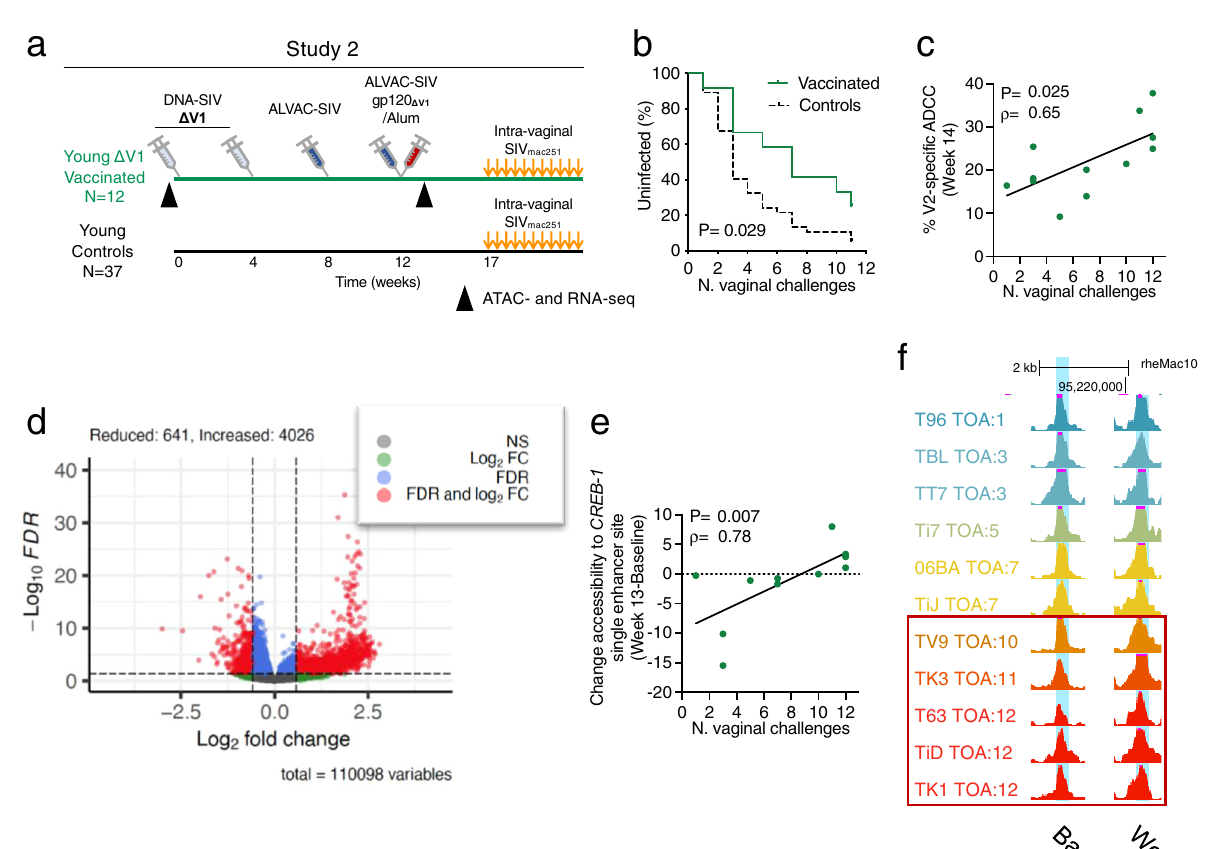
Fig. 3 | Chromatin accessibility to CREB1 . V2 speci fi c ADCC and risk of SIV acquisition. a Schematic study design with time of immunization (weeks 0 – 12) or SIV mac251 challenges (weeks 17 – 27) and time of collection of ATAC- and RNA-seq samples (black triangle). b SIV mac251 acquisition. The number of intravaginal exposures before viral acquisition was assessed in n =12 young animals relative to n =37 historic controls (Log-rank Mantel-Cox test). c Two-tailed Spearman corre- lation and simple linear regression between V2-speci fi c ADCC at week 14 and time of acquisition (TOA) in n =12 animals. d Volcano plot showing in red ATAC-sites with signi fi cantly (FDR<0.05) different accessibility at baseline and week 13 and with absolute fold-change higher than 1.5 (Log 2 =0.585). Reduced accessibility: 641 sites, Increased: 4026. Blue dots: sites with signi fi cantly different accessibility, but lower absolute fold-change. Green dots: sites with not signi fi cantly different accessibility, but absolute fold-change higher than 1.5. Gray dots: sites with not